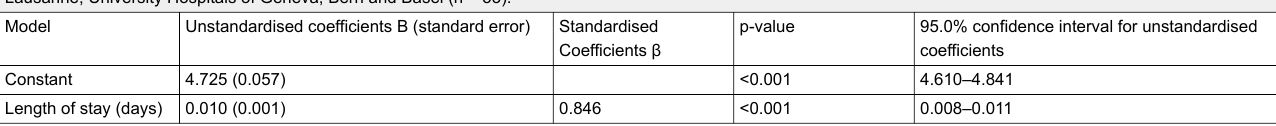
Table S4: Summary of regression coefficients – linear regression model predicting decadic logarithm of total costs per case. Study population: discharges from CHUV Lausanne, University Hospitals of Geneva, Bern and Basel (n = 53).